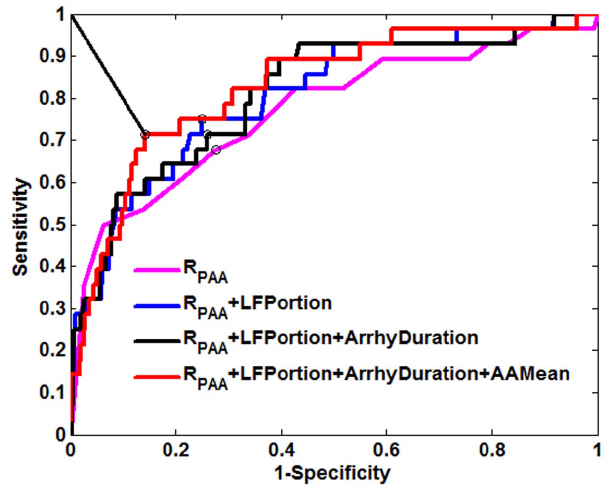
Figure 9. ROC curves of the scores obtained by stepwise logistic regression. ROC curves for the logistic regression models with successive inclusion of the variables: RPAA, LFPortion, Arrhythmia Duration, AAMean . The circles indicated the best cut off points for each model.